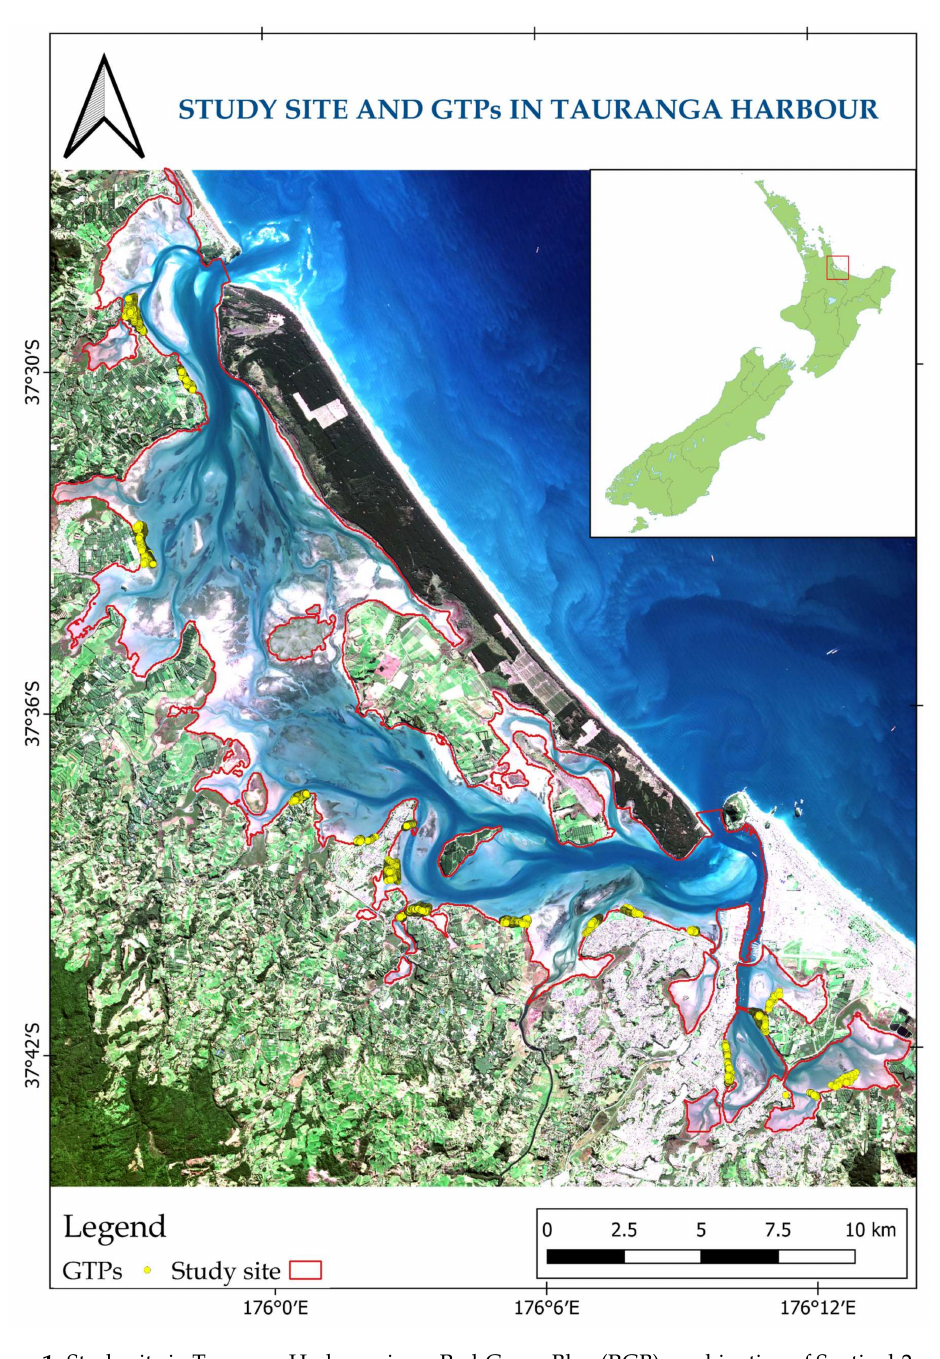
Figure 1. Study site in Tauranga Harbor using a Red-Green-Blue (RGB) combination of Sentinel-2 scene (5 / 1 /